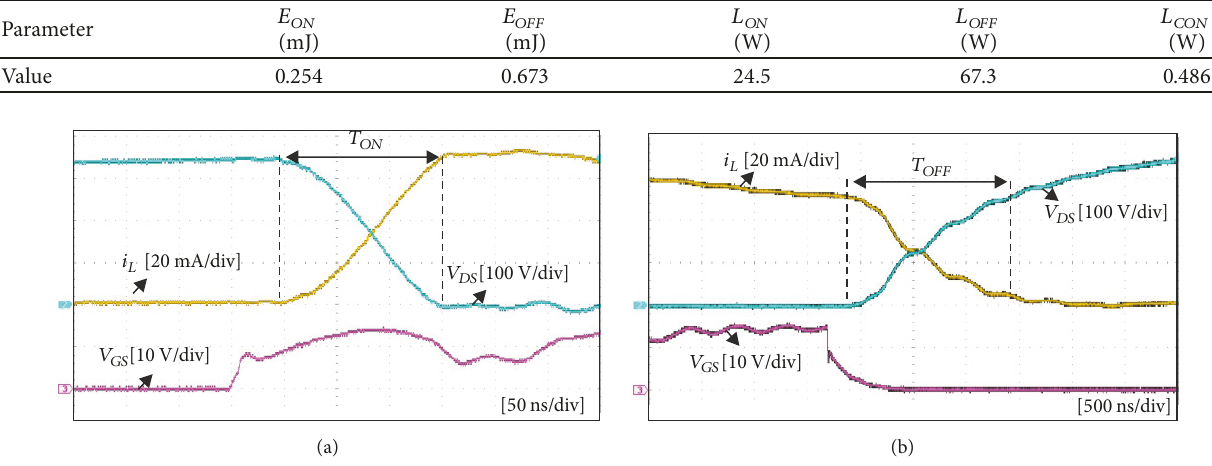
Table 3: Results of the losses analysis at 𝐹 𝑆𝑊 = 100 kHz and 𝑖 𝐿 = 6 A.